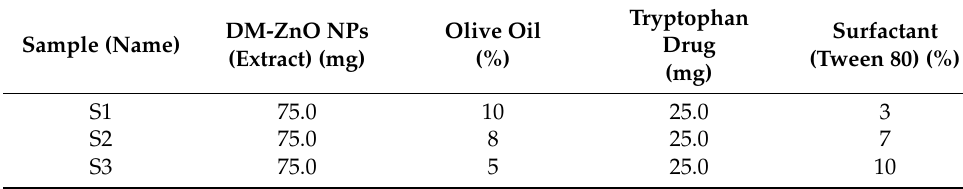
Table 1. Conditions for nanoemulsion